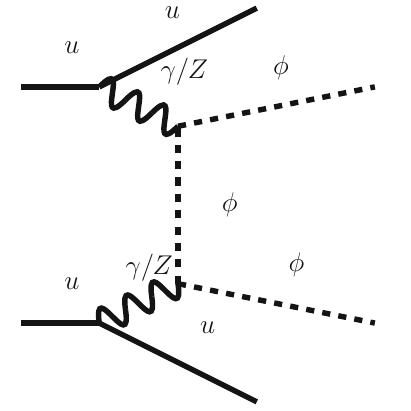
Fig. 14 Example of a Z /γ fusion diagram